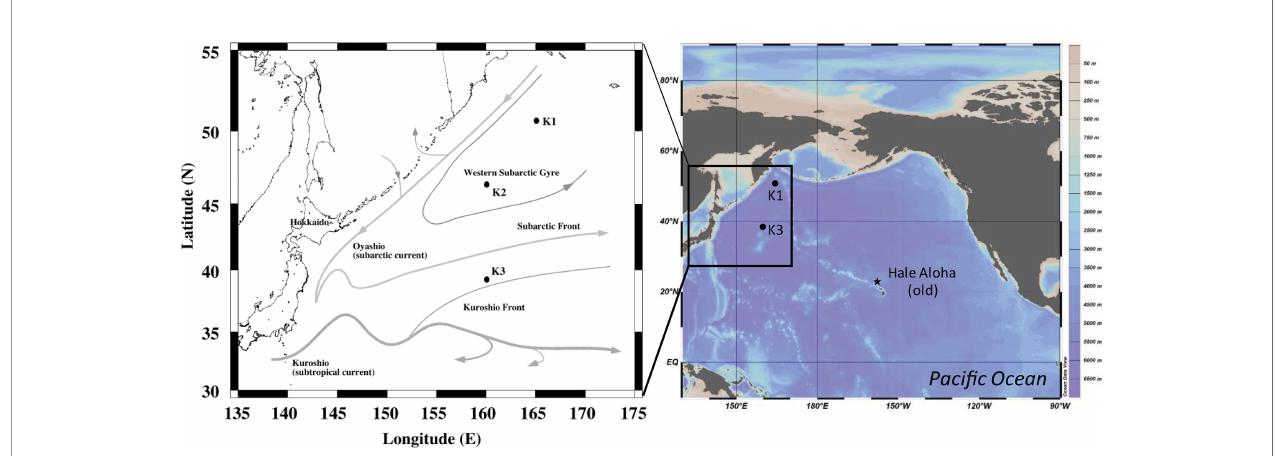
FIGURE 1 | Location of stations K1 and K3 investigated in the North-West Paci fi c. Station K2 investigated during the VERTIGO project is shown. Old station Hale Aloha, also investigated in this study, is located north of Hawaii Island, south of station